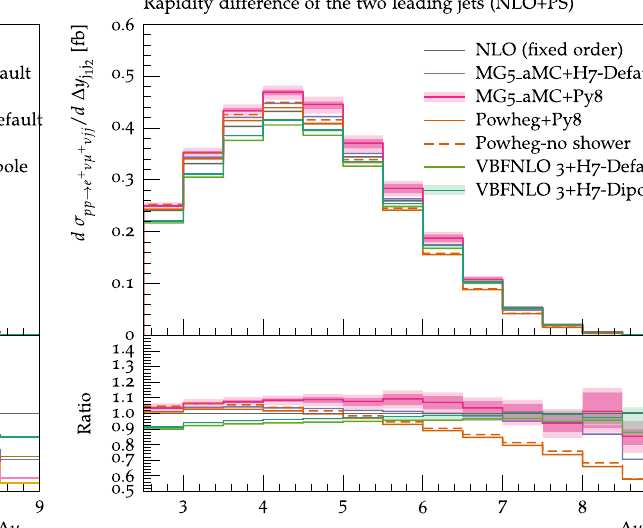
shown, while for MG5_aMC + Pythia8 the darker and lighter bands correspond respectively to the nine-point scale uncertainty and the scale and PDF uncertainties combined linearly. The predictions are obtained in the fiducial region described in Sect.